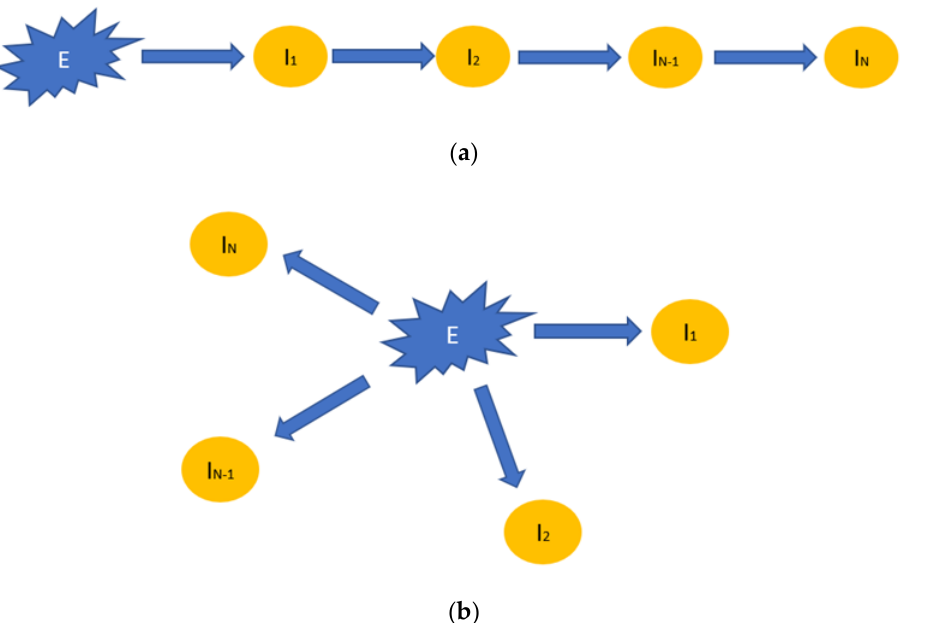
Figure 1. ( a ) Failure typology 1: Cascading effect (E: Earthquake, Ii: Infrastructures). ( b ) Failure typology 2: Common cause (E: Earthquake, Ii: Infrastructures).